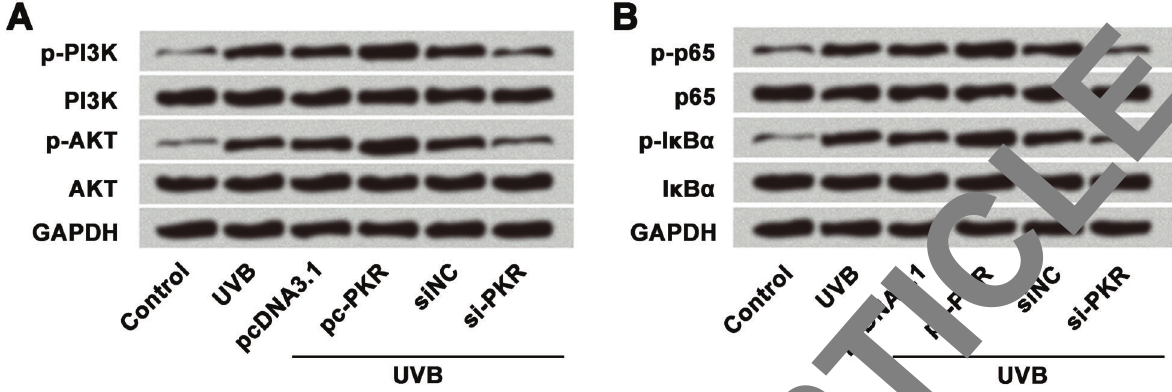
Figure 7. Western blotting analysis of PKR on PI3K/AKTand NF- k B signaling pathways, which suggested that overexpression of PKR activated A , PI3K/AKT pathway and B , NF- k B pathway. UVB treatment time was 16 h. UVB: ultraviolet B; PKR: RNA-dependent protein kinase; PI3K: phosphatidylinositol-3